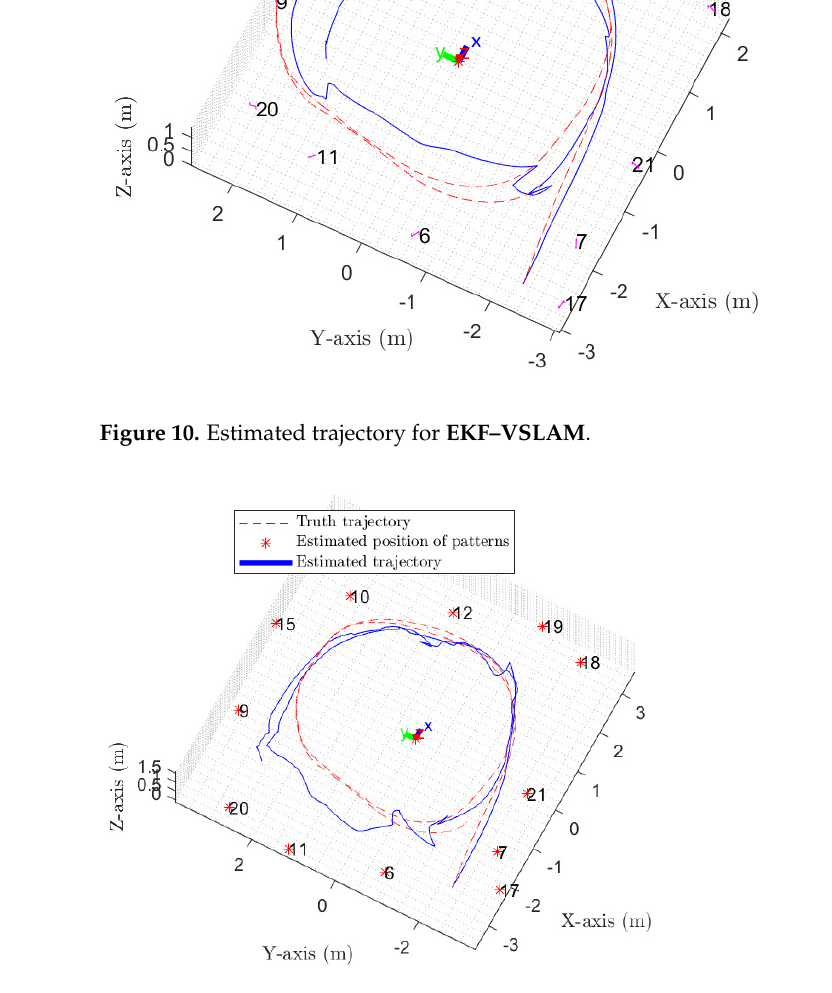
Figure 11. Estimated trajectory for LG–EKF–VSLAM